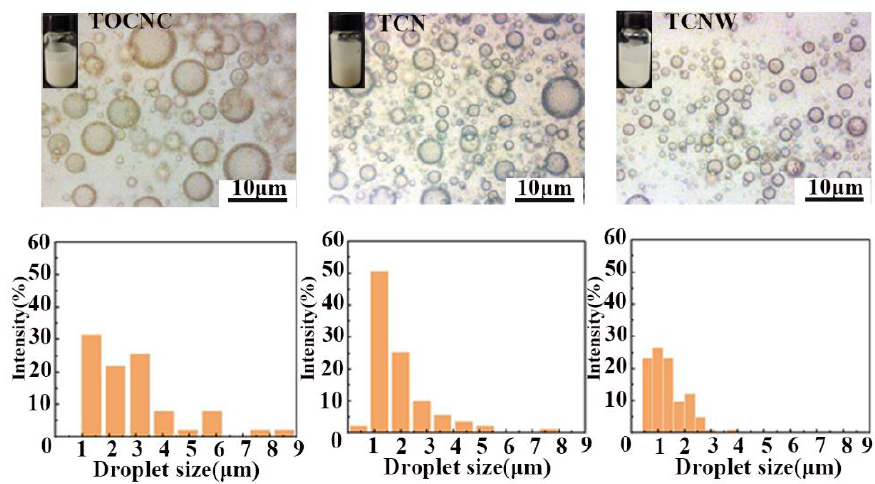
Figure 4. Optical micrographs and droplet size distribution of emulsions.